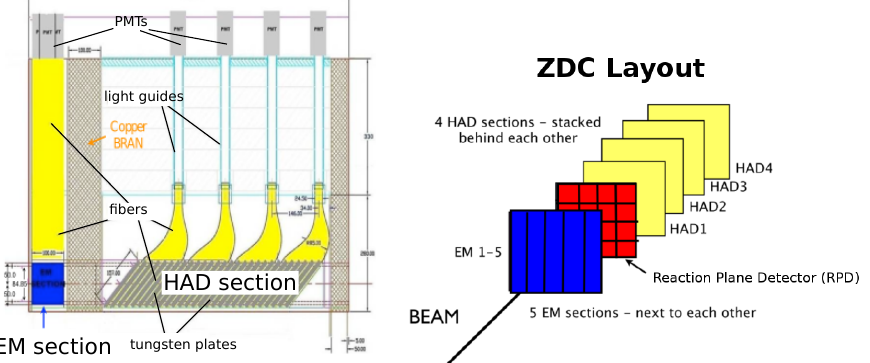
Figure 1. The side view of the CMS Zero Degree Calorimeter ( left ) and the segmentation of each sections ( right ) [21].